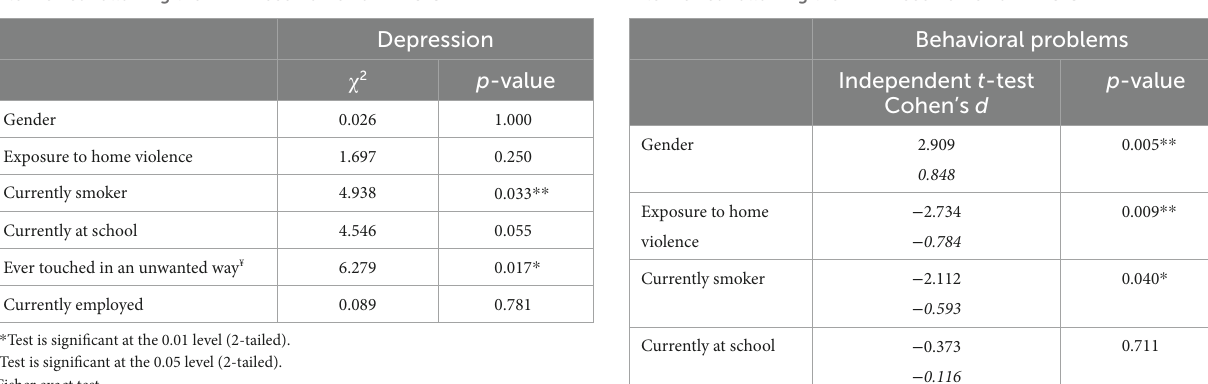
TABLE 3 Factors found associated to positive screen for behavioral problems among 52 Syrian adolescent refugees displaced to South Beirut interviewed following the HEEADSSS